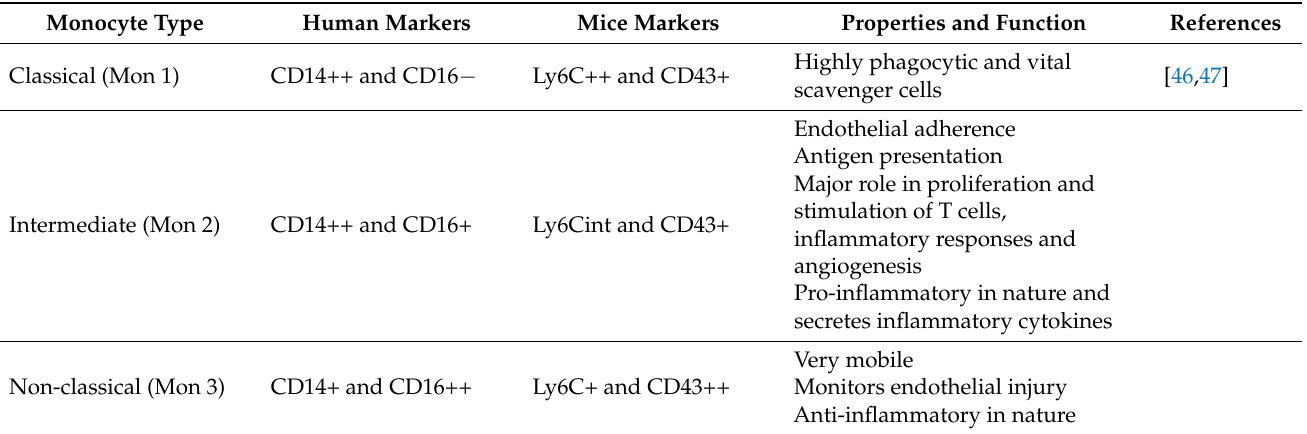
Table 1. Monocyte types and